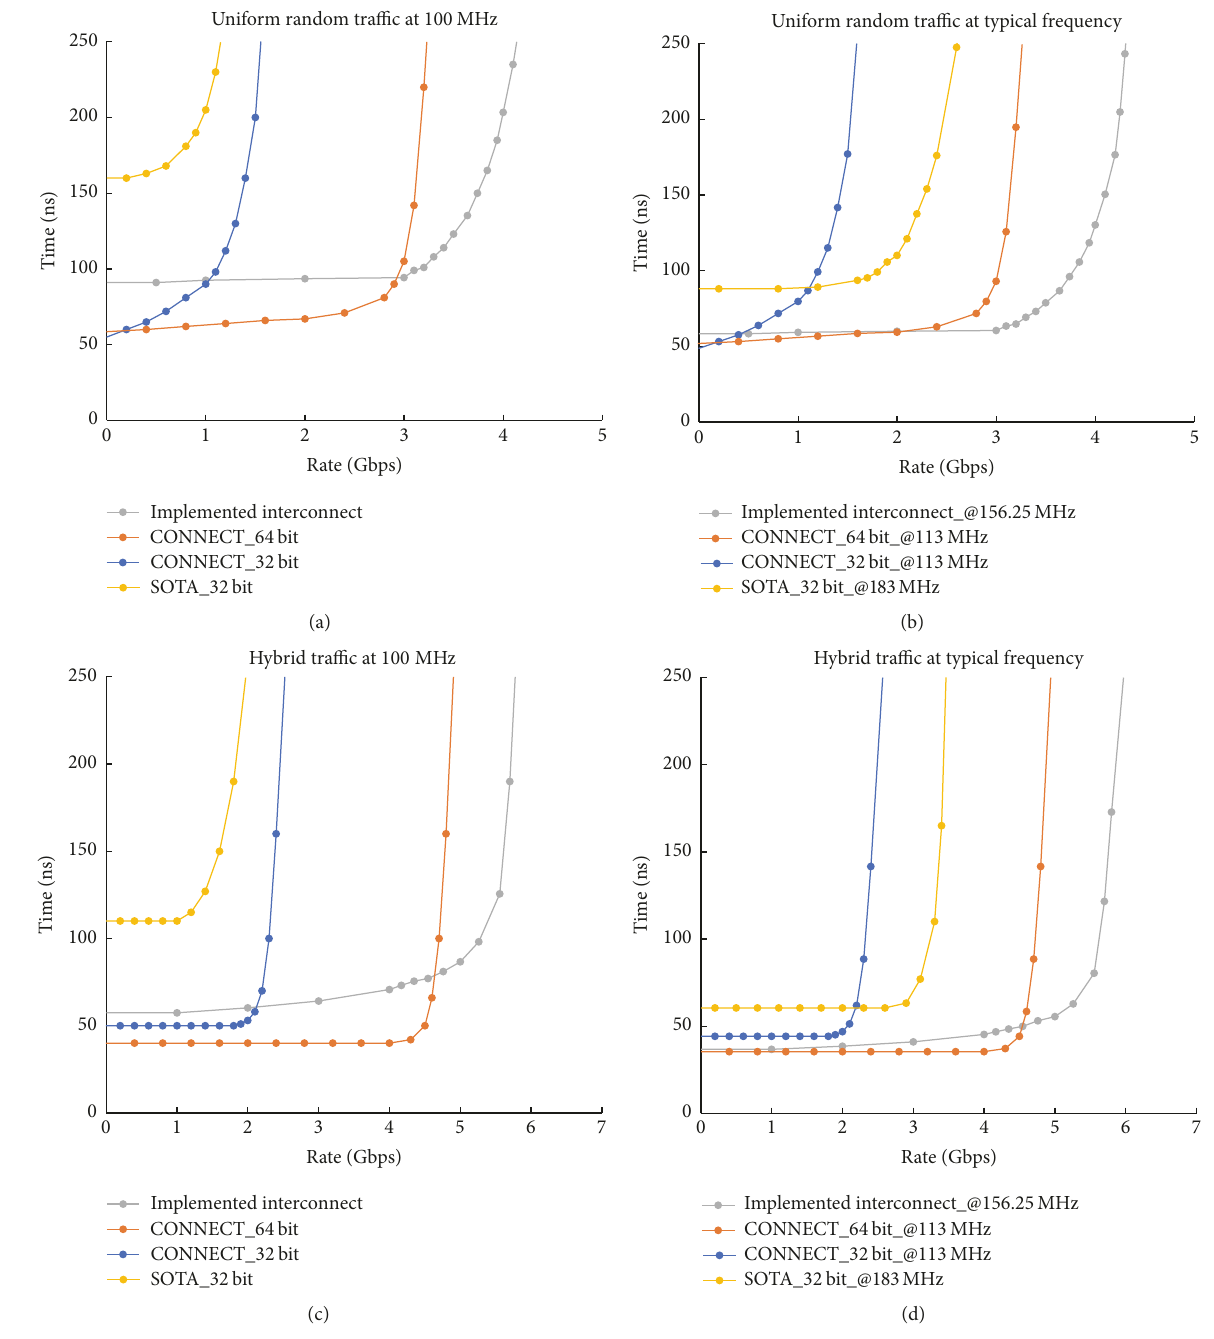
Figure 7: The comparison between the implemented interconnect system and the existing SOTA and CONNECT interconnect.